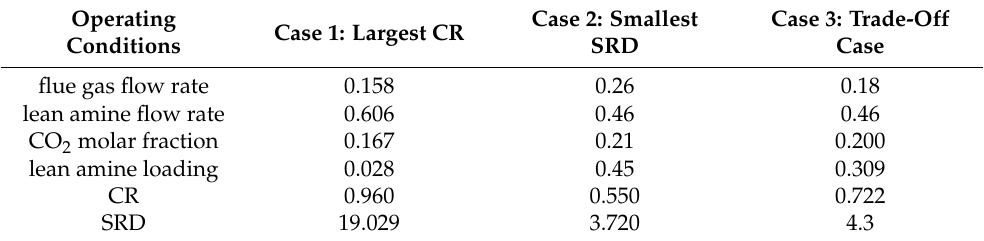
Table 6. Optimized operating conditions for PSO algorithm implementation. Case 1: Find the operating conditions that resulted in the largest CR without leveraging the value of SRD. Case 2: Find the operating conditions corresponding to the smallest SRD without leveraging the value of